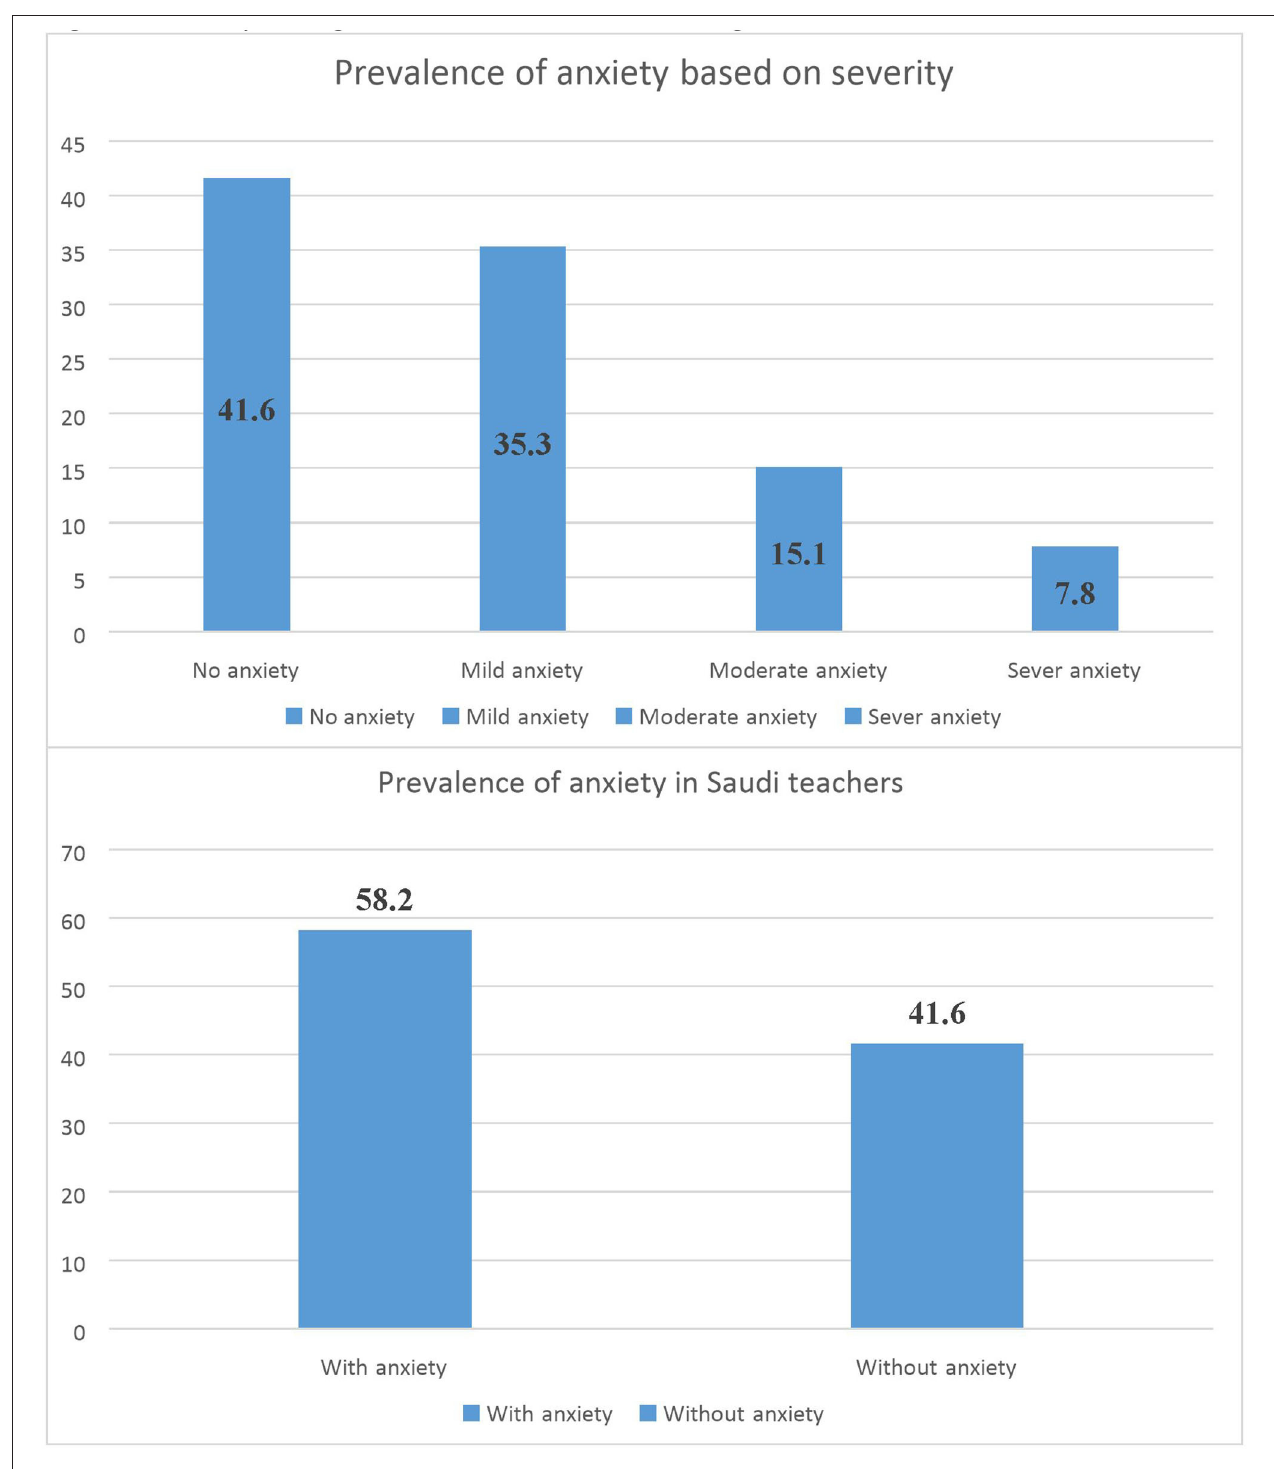
FIGURE 1 | Anxiety among teachers in Saudi Arabia during COVID-19 pandemic.